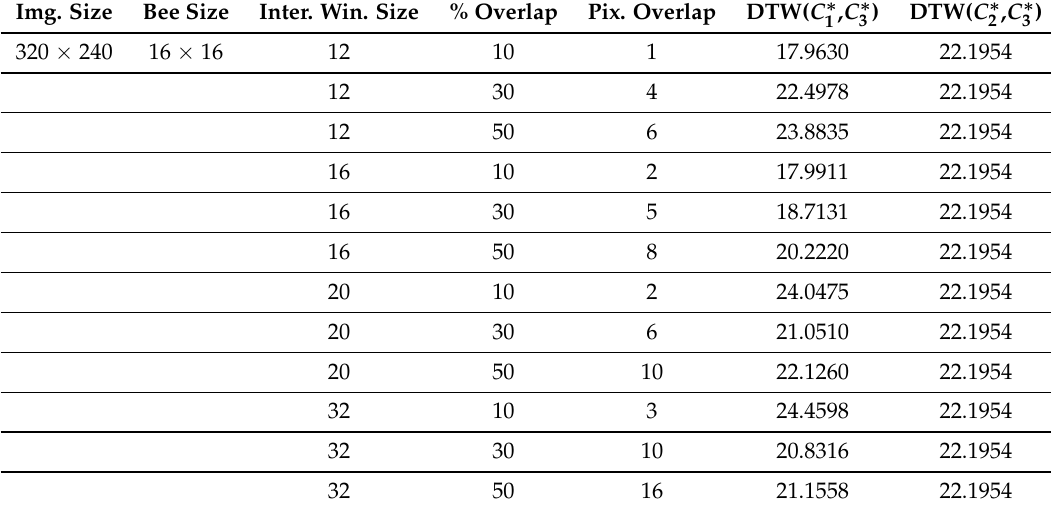
Table A9. DTW values for MT _ Vid . mp 4 with image size of 320 × 240; C ∗ and C ∗ is Human Count (ground truth). 3